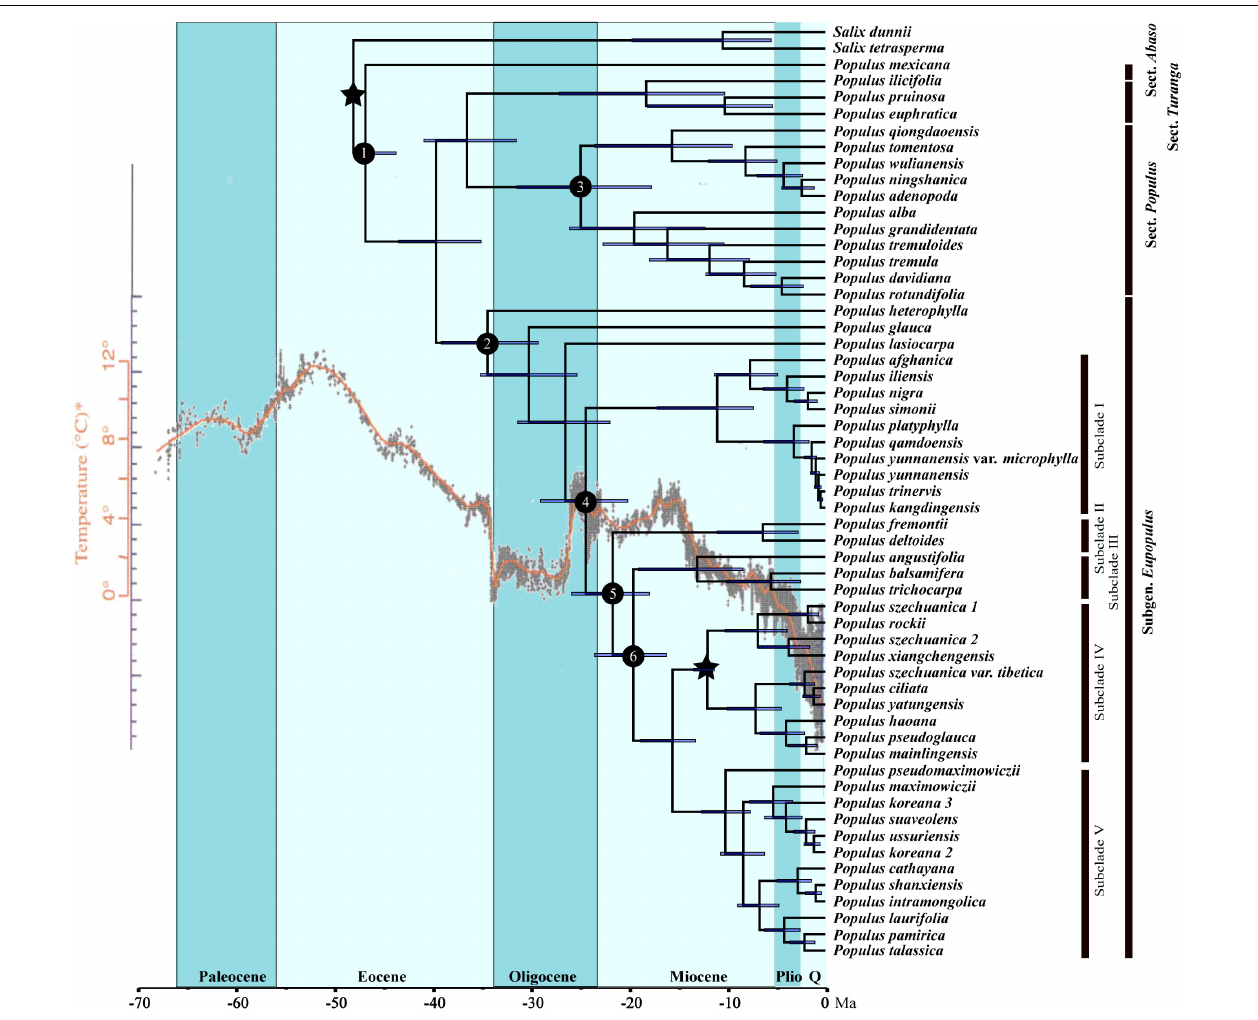
FIGURE 4 | Chronogram of Populus inferred from the MCMCtree program in PAML. Blue bars indicate the 95% highest posterior density credibility intervals for node ages. Star indicates the calibration point. Nodes of interests were marked as 1–6. Q, quaternary; HPD, highest posterior density; Ma, million years ago. The phylogenetic chronogram used temperature curve as modified from Zachos et al. (2001) as